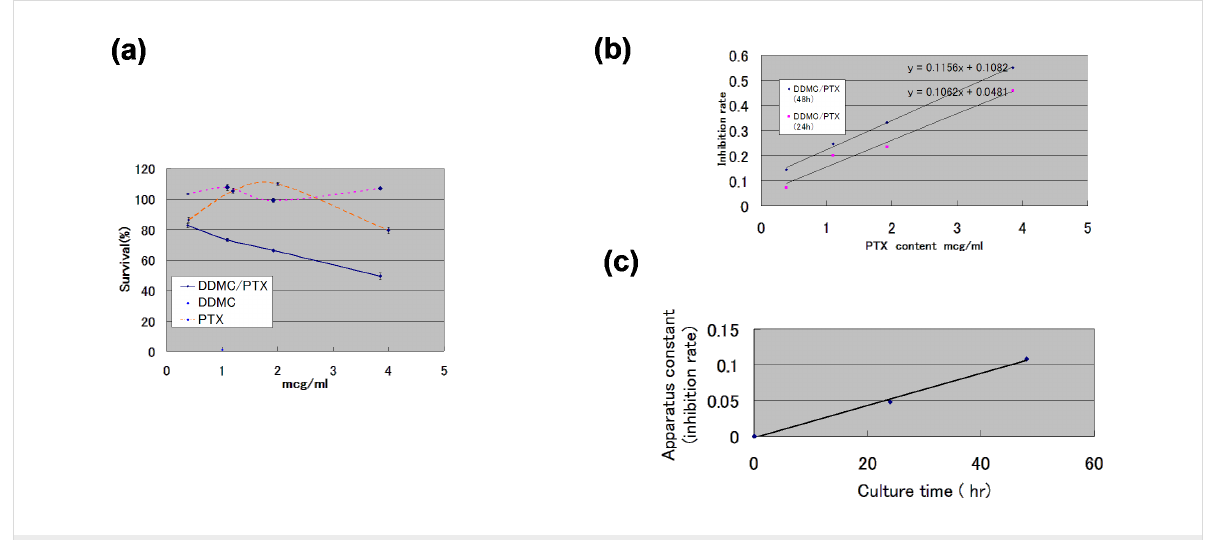
Figure 5: Anticancer efficacy of a supramolecular complex against PTX-resistant melanoma B16F10 cells. (a) Survival of B16F10 melanoma cells treated with paclitaxel or the DDMC–paclitaxel complex for 48 h determined by using the MTT (WST8) method (blue solid line: DDMC/PTX, purple dashed line: DDMC, orange dashed line: PTX). (b) Tubulin polymerization and cell death (Cd) rates can be expressed by enzymatic kinetic parameters. Relationship between Cd and paclitaxel concentration, [ E ] 0 , after 24 h and 48 h. After 24 h: Cd = 0.1062 [ E ] 0 + 0.0481; after 48 h: Cd = 0.1156 [ E ] 0 + 0.1082. (c) Apparatus constant (C 1 ) by cell culture time in WST8 vs time (h) for DDMC/PTX complex. Reprinted from